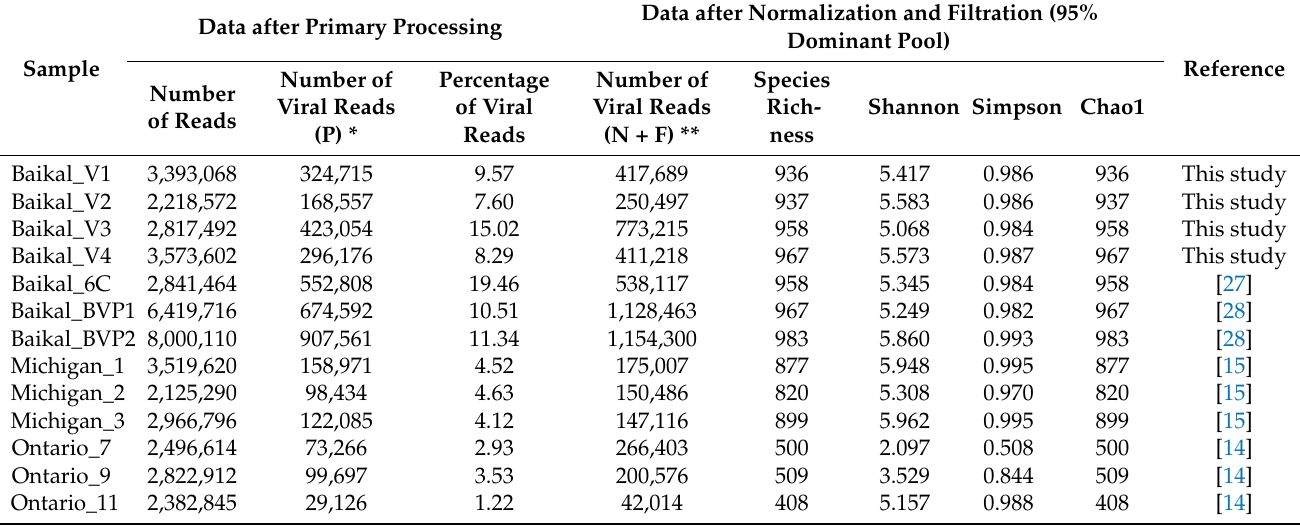
Table 3. General statistics and viral diversity indices for the datasets used in the